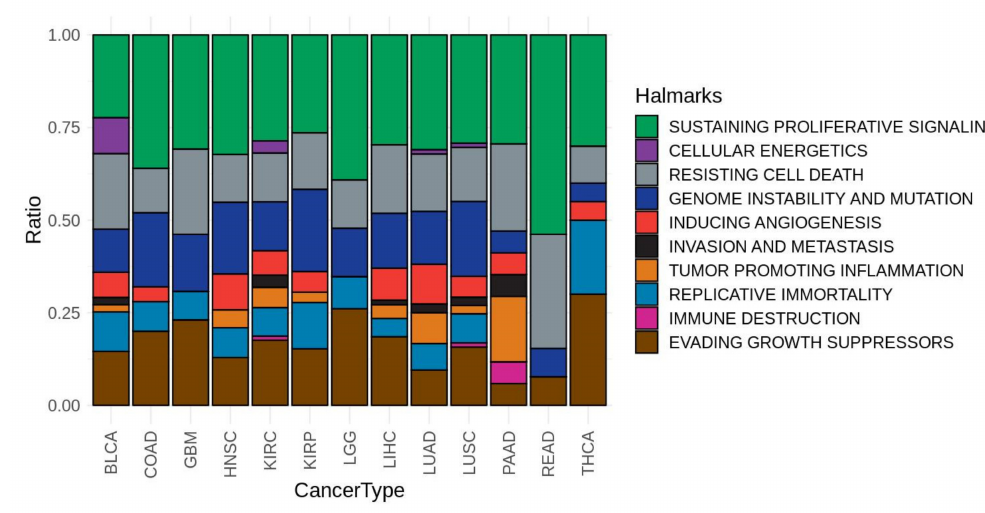
Figure 4. Cancer hallmarks a ff ected by GS-DSA circuits across cancer types.